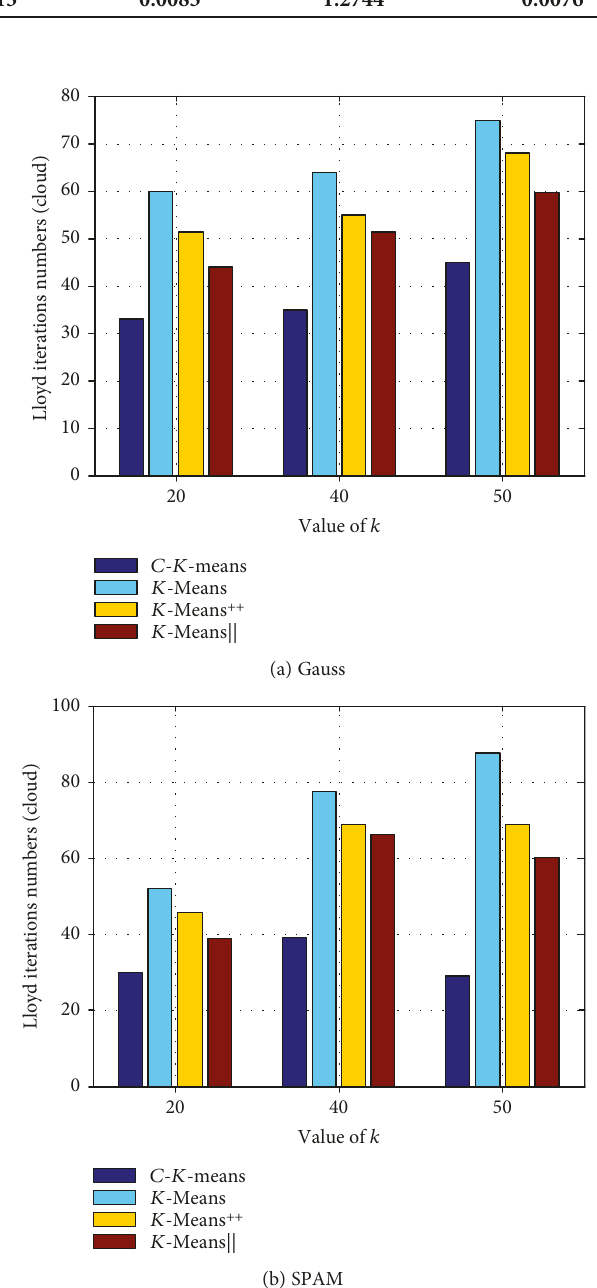
Figure 4: Numbers of Lloyd ’ s iterations until convergence (averaged over 10